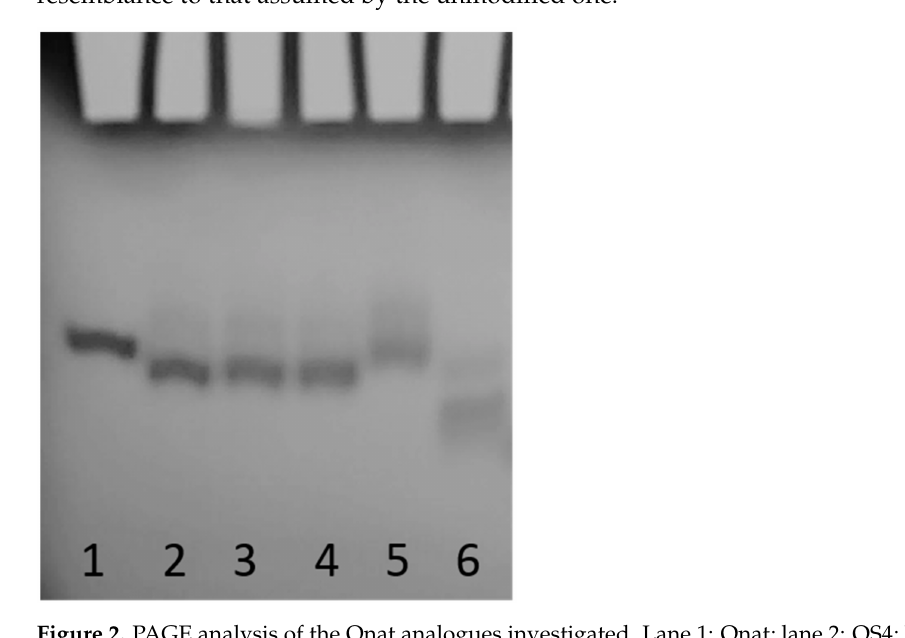
Figure 2. PAGE analysis of the Qnat analogues investigated. Lane 1: Qnat; lane 2: QS4; lane 3: QS8; lane 4: QS12; lane 5: QS16; lane 6: TT-Qnat. See Materials and Methods for experimental